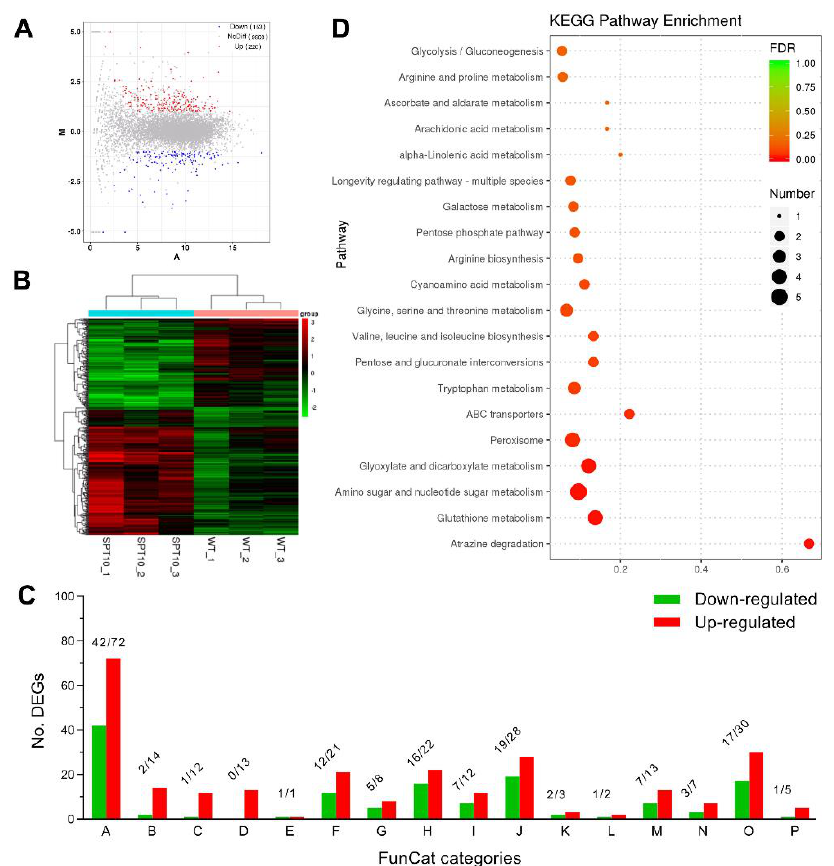
Figure 6. Features of Spt10-specific transcriptome in B. bassiana . ( A ) MA-plot analysis of the genes significantly upregulated, downregulated, and not differentially regulated (no-DEGs) in ∆ Spt10 versus WT. ( B ) Cluster analysis of differentially expressed genes (DEGs) in the transcriptomes based on the 4-day-old SDAY cultures of ∆ Spt10 and WT strains grown at 25 ◦ C. ( C ) FunCat annotation for 16 functional categories of significantly regulated genes in ∆ Spt10 versus WT. Capital A: